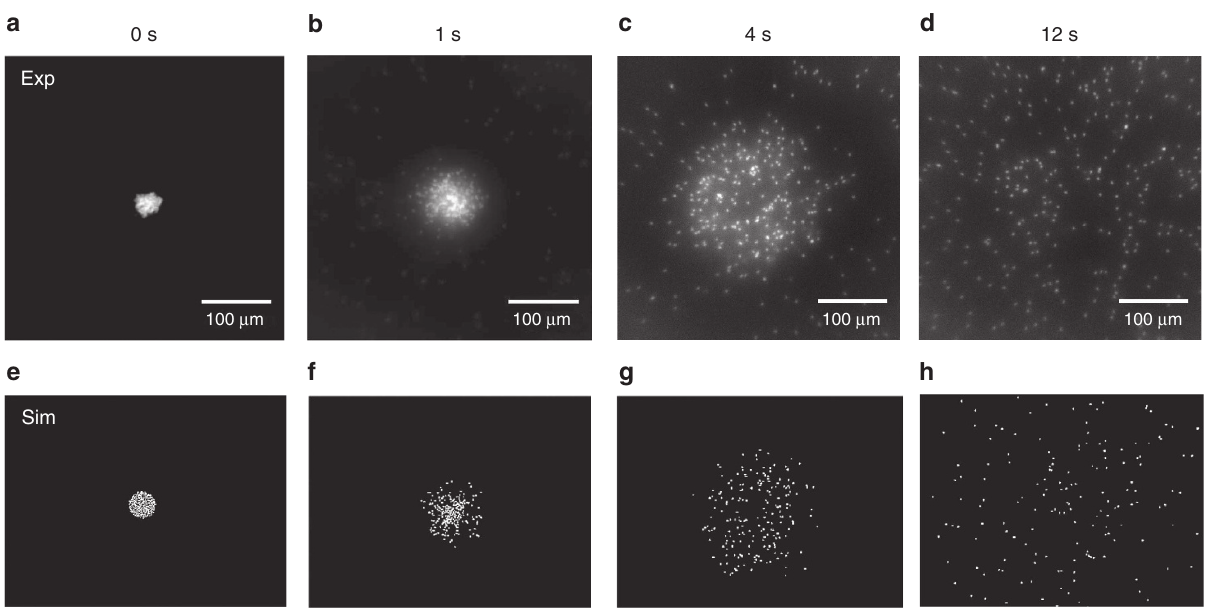
Figure 3 | ‘Explosion’ of active crystal. Explosion of swimmer crystal in ( a – d ) experiments and ( e – h ) Brownian dynamics simulations. ( a , e ) A strong trapping force draws the swimmers into a dense close-packed 2D crystal. ( b , f ) A subsequent release of the trap frees the swimmers, causing the crystal to explode. ( c , g ) At later times, a ballistic shock propagates outward like a travelling wave. ( d , h ) At long times, the swimmers spread diffusively.